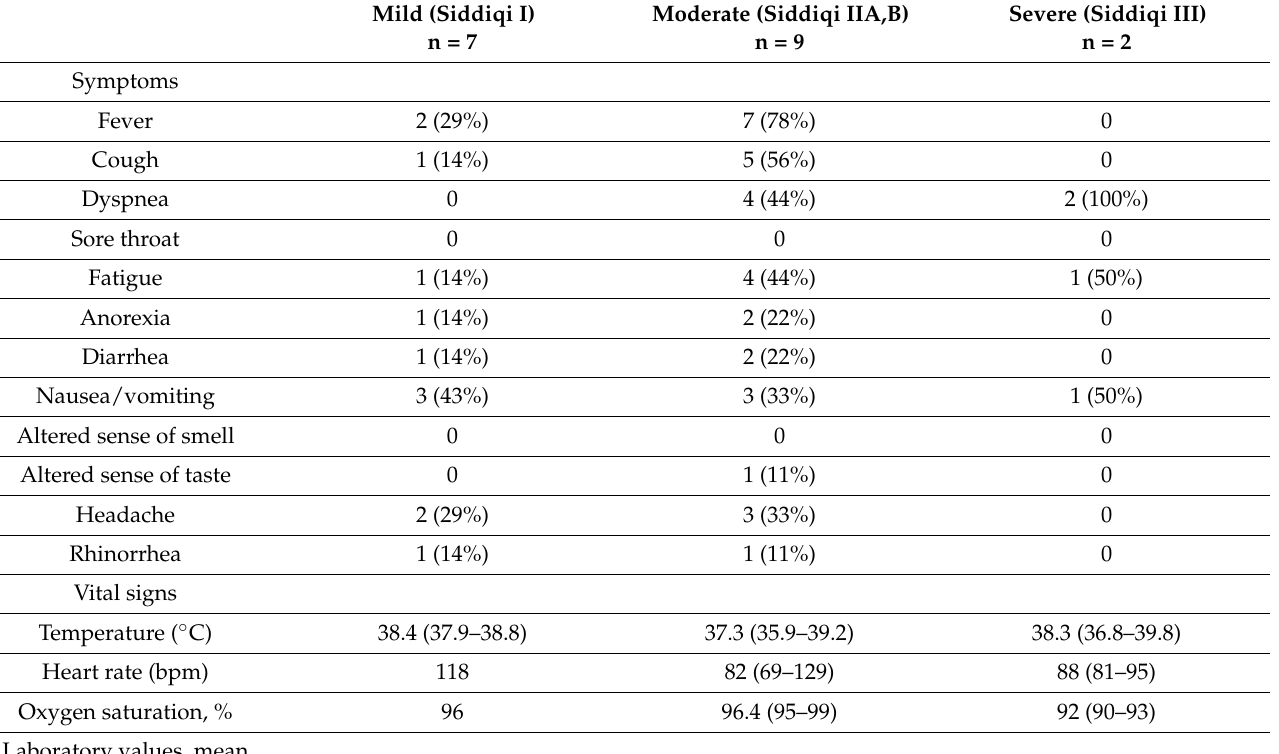
Table 2. Symptoms, signs and laboratory